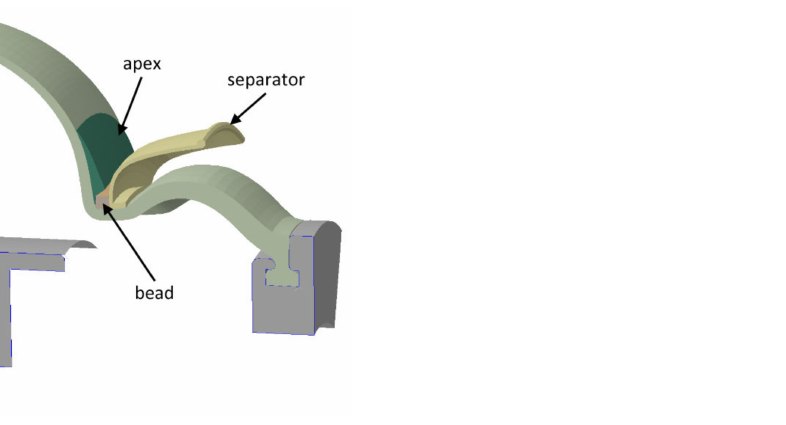
Figure 2. Mounting the apex on the bead using an inflated bladder on a DAM machine (symmetrical half view).